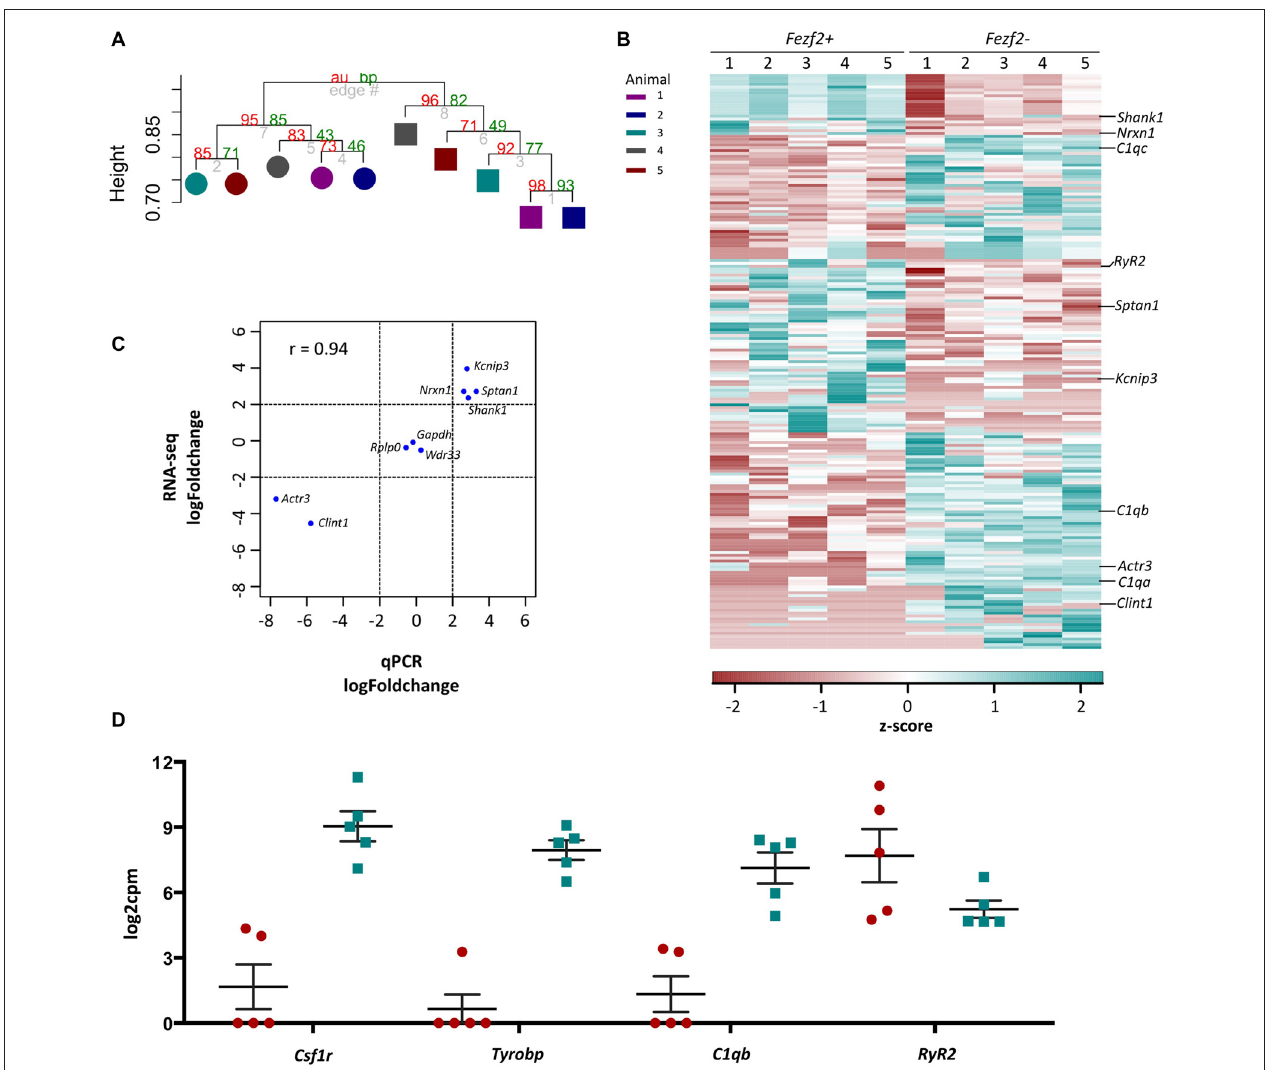
FIGURE 4 | RNA-sequencing analysis of Fezf2+ve and Fezf2 − ve IT-PNs. (A) Unsupervised correlation cluster analysis of the top 8% most variable genes across all samples. The approximately unbiased (au) p -value is shown as a percentage in red and the bootstrap (bp) p -value is in green. The Fezf2+ve and Fezf2 − ve IT-PNs separate into two main clusters with an AU p -value > 95. Color key indicates the pairing of samples based on the animal from which they were isolated. (B) Heatmap of all significantly changed genes identified between Fezf2+ve and Fezf2 − ve IT-PN samples. Relative changes in gene expression are represented by the z-score of transformed counts for each individual sample. (C) Pearson’s correlation analysis of the log fold change for nine genes as analyzed by qPCR data and RNA-seq. A significant positive relationship was observed ( p = 0.0002). (D) Graph shows the log2cpm in Fezf2+ve and Fezf2 − ve IT-PNs of genes of interest, including several microglia-associated